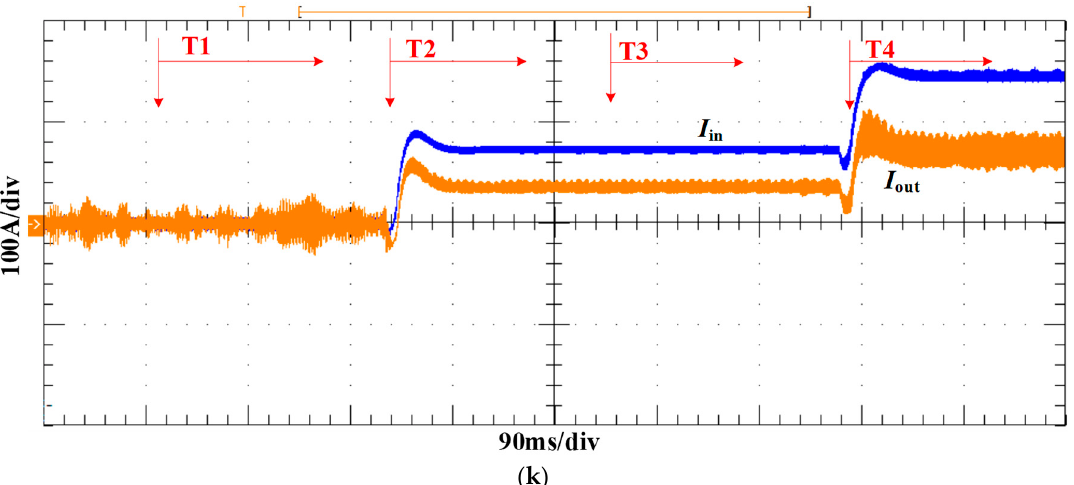
Figure 7. Voltage and current output waveforms. ( a ) Three-phase grid currents. ( b ) Two-phase traction currents. ( c ) Two- phase output currents of MP-PC. ( d ) The t/u-phase arm currents of MMC. ( e ) The v/w-phase arm currents of MMC. ( f ) The circuiting currents of the four bridge arm of MMC. ( g ) The dc currents flowing through the dc-link of MMC. ( h ) The capacitor voltages of the t-phase bridge arm of MMC. ( i ) The dc-link voltage of MMC. ( j ) The dc-bus voltage of dc/dc converters. ( k ) Input and output currents of dc/dc converters.